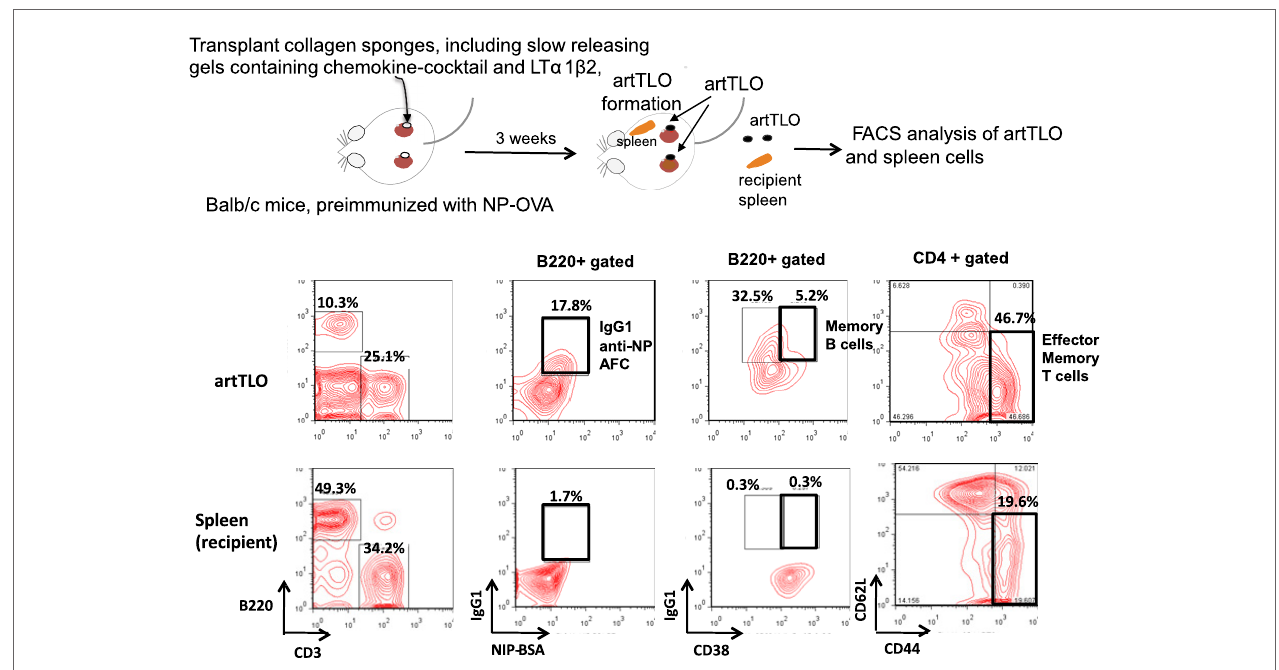
FigUre 2 | accumulation of antigen-specific memory B cells and cD4 positive T cells in artTlOs . artTLOs were constructed in Balb/c mice, which had been preimmunized with 100 μ g NP-hapten conjugated ovalbumin (NP-OVA) in alum as described in the Section “Materials and Methods.” After 3 weeks, artTLO were formed in the subcapsular space of kidney. artTLO and spleen were removed from recipients for flow cytometer analysis. Flow cytometer profiles of artTLO and spleen cells of recipient mice are shown. Note that IgG1 class anti-NP antibody-forming cells as well as memory B cells and effector memory T cells are remarkably enriched in artTLOs, compared to the recipient spleen cells. Representative data are shown from FACS analysis of 10 individual artTLO. Data were highly